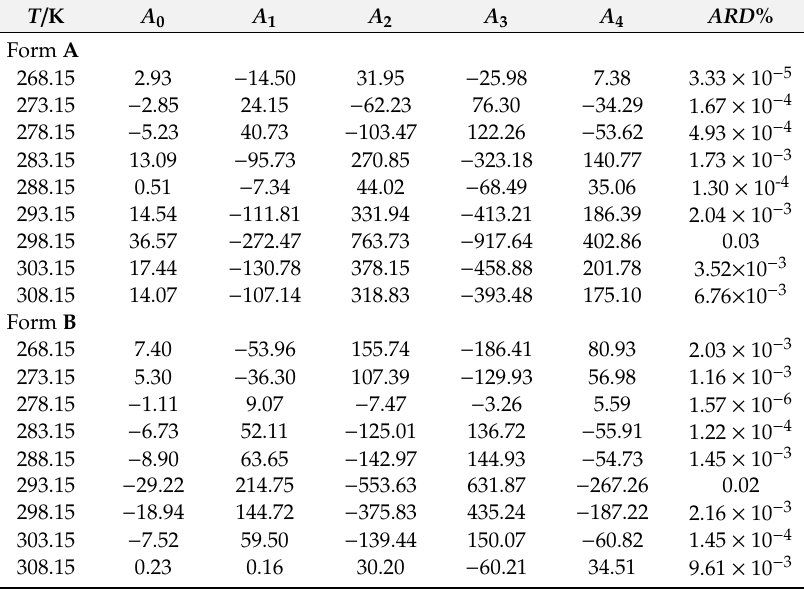
Table 5. Parameters of CNIBS / R–K model for MTBE + toluene system.